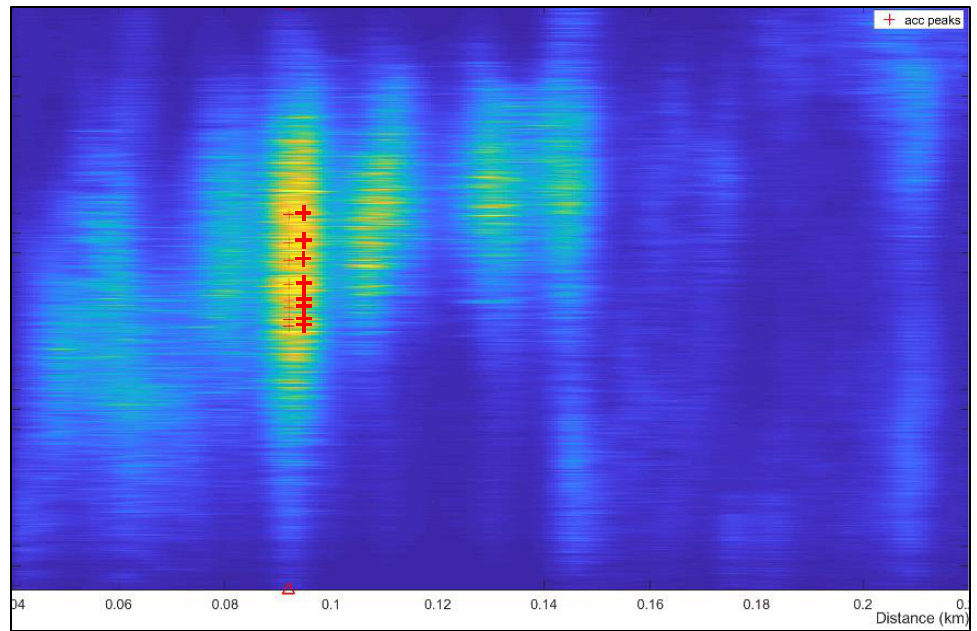
Figure 9. Train consist convolution with a gap of 25 mm and a speed of 25 km/h.